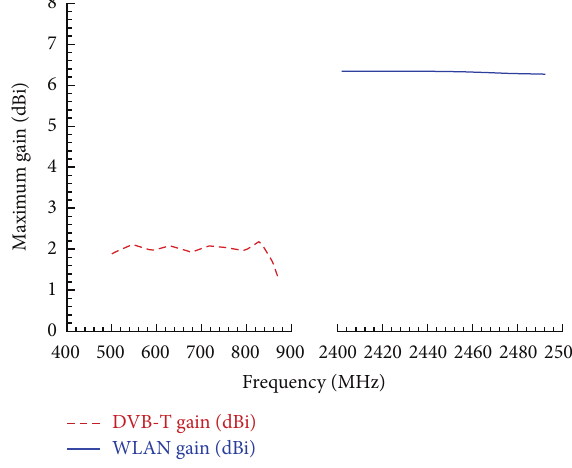
Figure 13: Simulated gain for the proposed dual-band L-shape PIFA as a function of